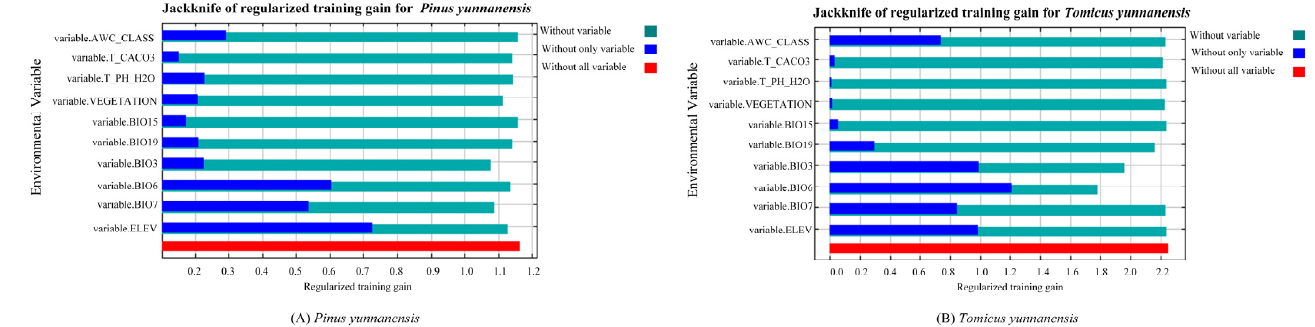
Figure 4. Jackknife test of variable importance in the species (( A ) P. yunnanensis ; ( B ) T. yunnanensis ).